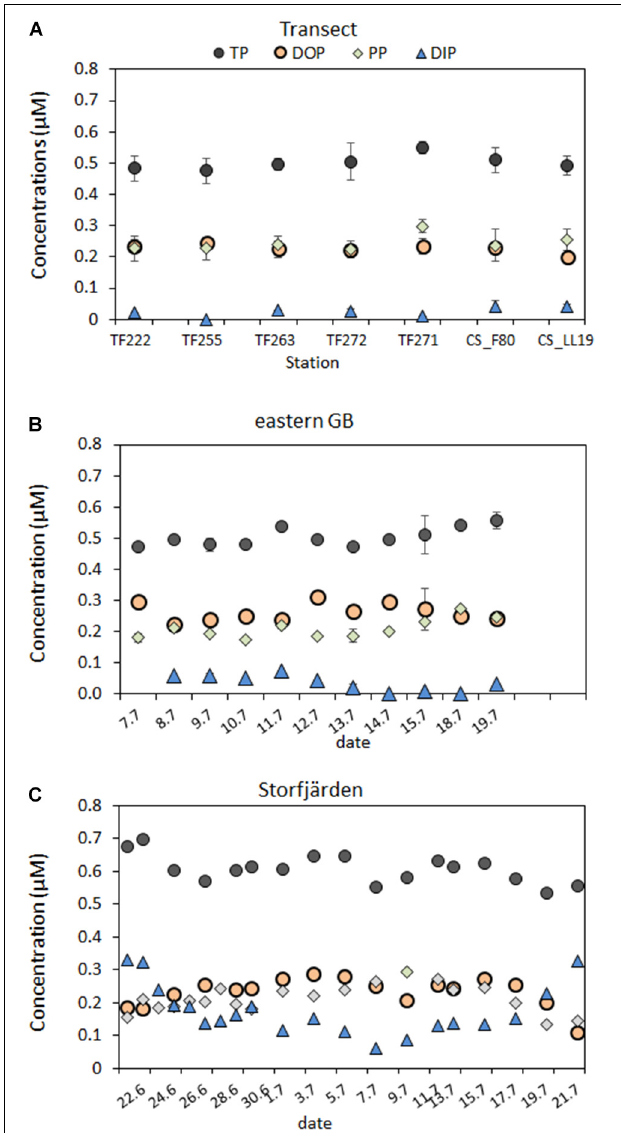
FIGURE 2 | P-pool sizes (in µ M) for the mixed surface layer above the thermocline along the transect through the Baltic Proper (A) and of the time series in the eastern GB (B) and in the Storfjärden (C) . Means of the 1 and 10 m are used for the transect and the eastern GB and for a depth integrated sample in the Storfjärden.